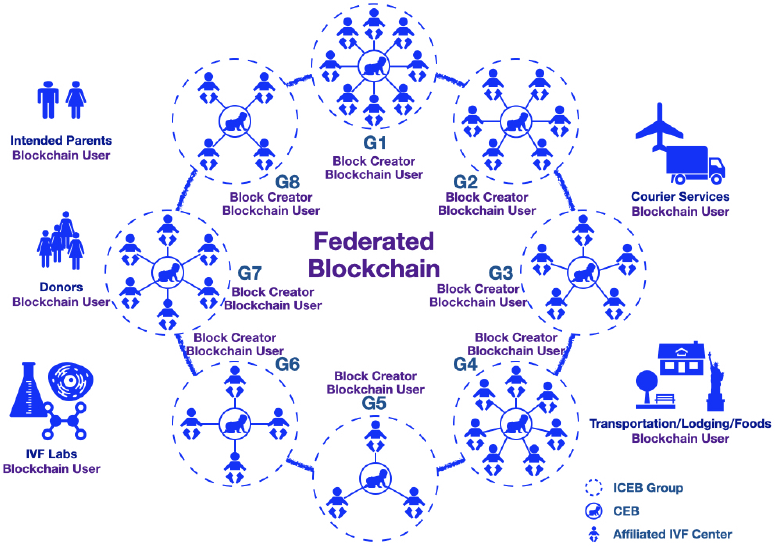
Figure 4. Block creators and blockchain users in the federated egg banking blockchain